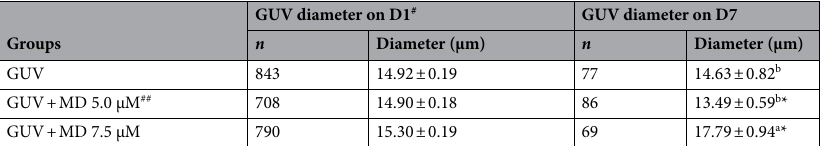
Table 2. Effect of menadione (MD) on the diameter of giant unilamellar vesicles (GUVs) co-cultured in vitro with bovine embryos. Data are expressed as the mean ± standard error of four independent replicates. # D1 = day 1 (beginning of cultivation); D7 = day 7 (end of 168-h cultivation). ## Embryos were cultured for 7 days, and menadione (5.0 μM or 7.5 μM) was included in the medium only on the sixth day of culture (from D6 to D7). ab Different letters in each column indicate significant differences ( P < 0.05). The asterisk (in the same row) indicates a significant difference within the same treatment when evaluated on different days ( P < 0.05).